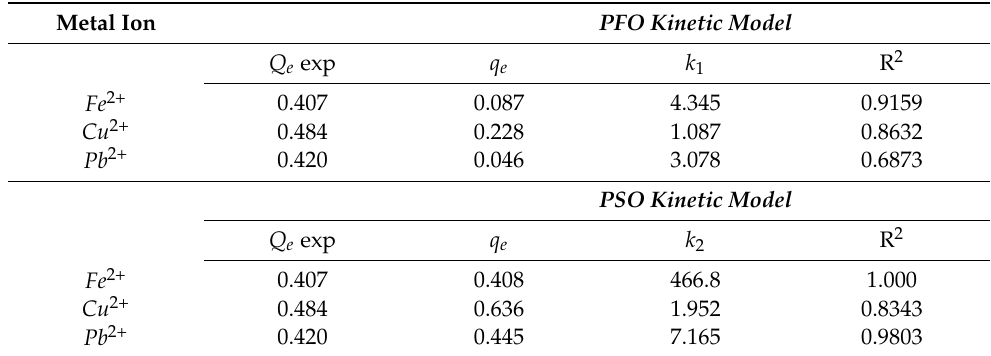
Table 2. PFO and PSO kinetic model constants for the adsorption of the Fe 2+ , Cu 2+ , and Pb 2+ by MXM